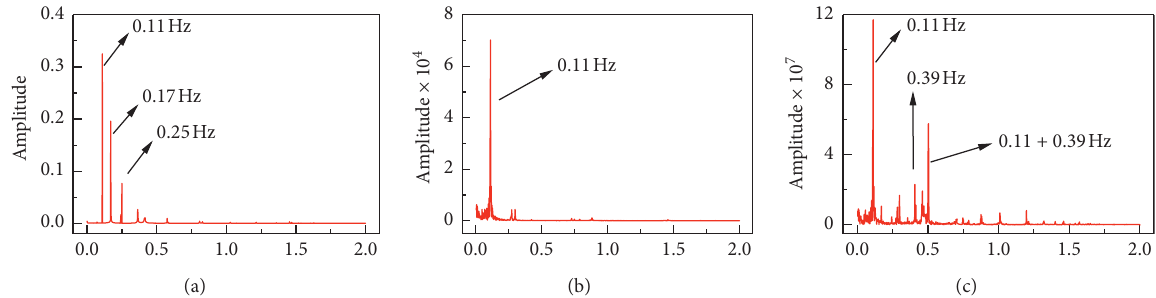
Figure 13: Power spectra of the (a) vertical, (b) lateral, and (c) torsional buffeting displacements at the midspan (#15) of Case 1. AoA � 0 °